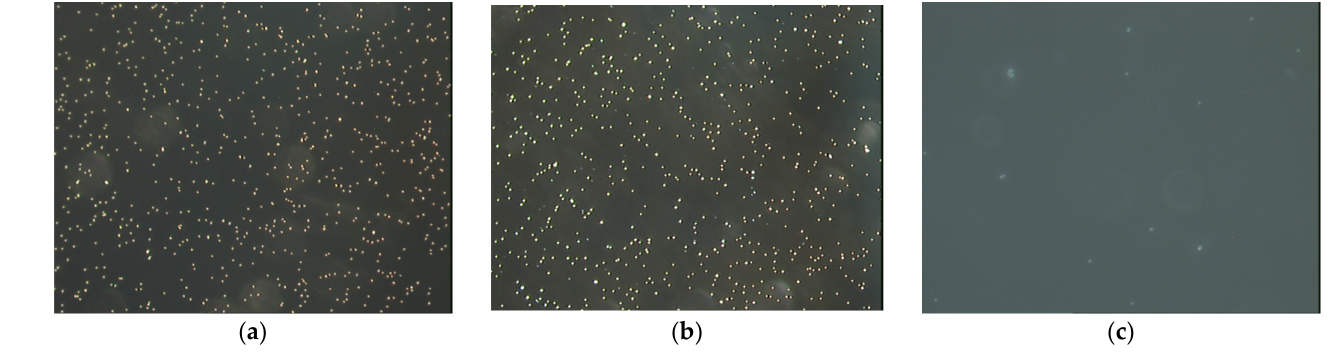
Figure 5. Micrographs of the SAL immunolatex particles on mica acquired in situ by optical microscopy; 1 mM NaCl, deposition time 120 min, micrograph size: 135 µm × 100 µm. ( a ) pH = 3.5, ( b ) pH = 4, (c) pH = 5–7.4.